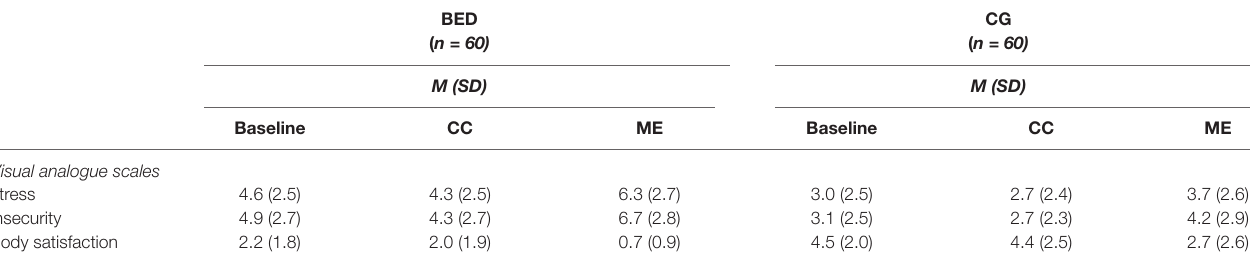
TABlE 3 | Means (M) and standard deviations (SD) for questionnaire assessment during thought-sampling for women with binge eating disorder (BED) and women with overweight and obesity (CG).